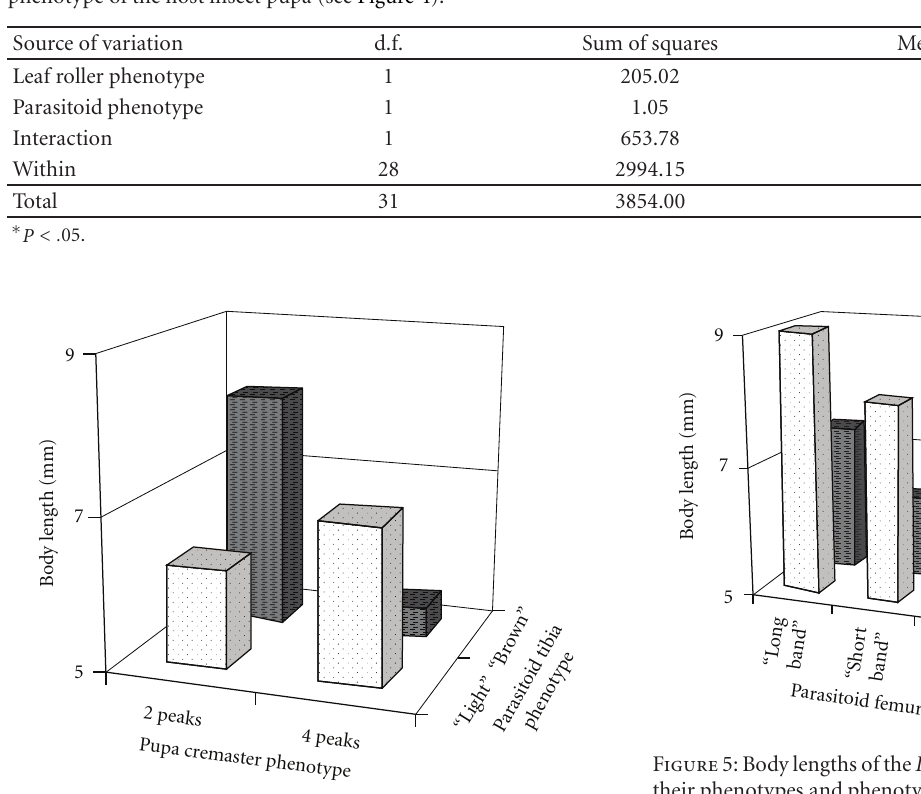
Figure 4: Body lengths of the I. maculator males in dependence on their phenotypes and phenotypes of their host insect pupae (results of two-way ANOVA in Table 1).